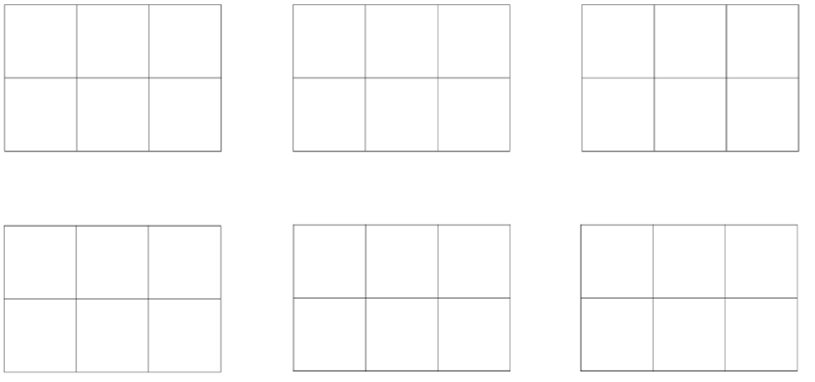
Figure 3. Assignment of the Task